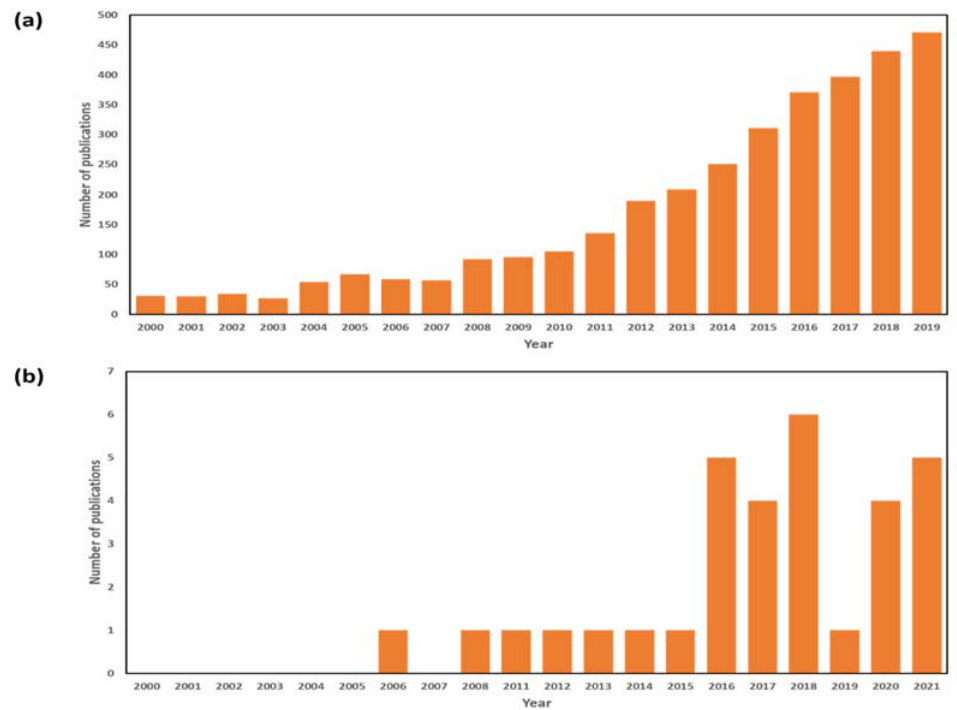
Figure 1. Number of publications on ( a ) ‘membrane distillation’, and ( b ) pilot scale MD studies between 2000 and 2020